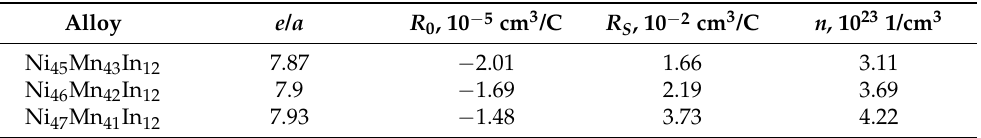
Table 4. The valence electron concentration e / a , normal R 0 , and anomalous R S Hall effect coefficients and concentration of charge carriers n for the Ni 47 − x Mn 41+x In 12 (x = 0; 1; 2) alloys.